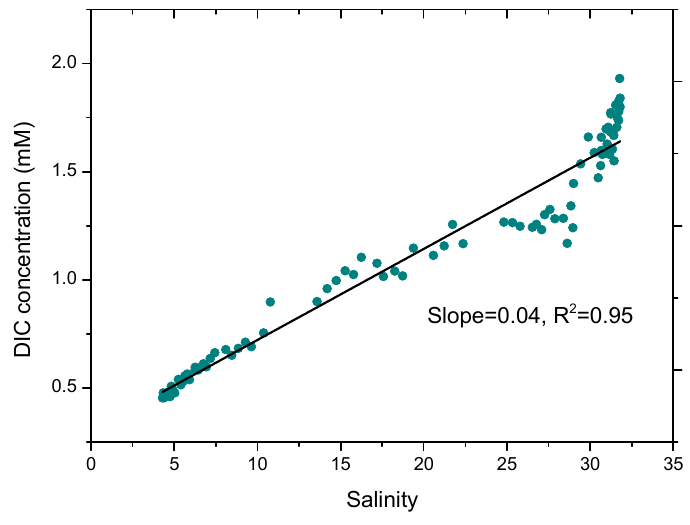
Figure 8. Correlation between DIC and salinity.